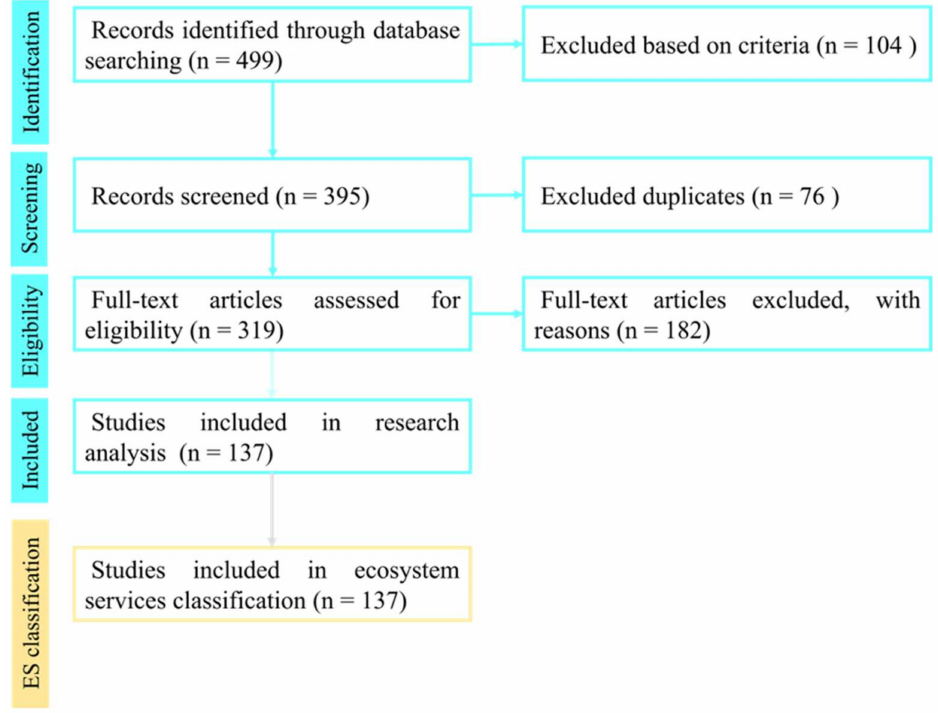
Figure 1. PRISMA flow chart for the SLR search of papers (adapted, original retrieved from